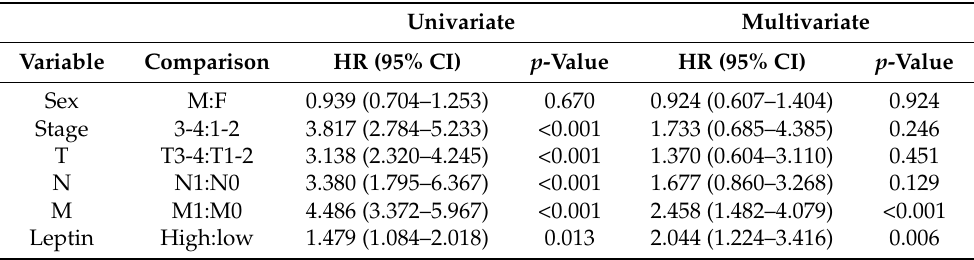
Table 1. Cox univariate and multivariate regression analyses of the TNM prognostic factors, patho- logical stage, and leptin level for overall survival in 603 patients with renal cell carcinoma.